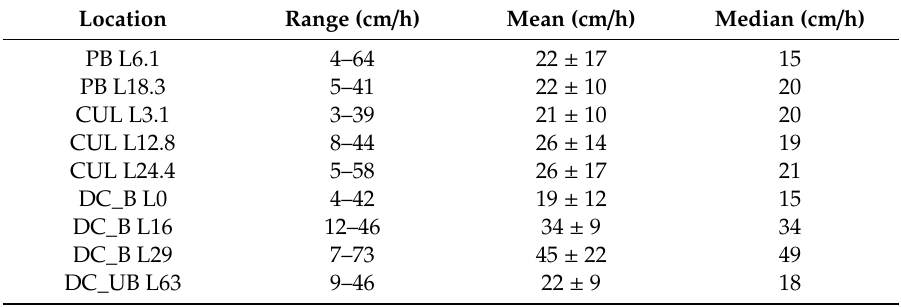
Table 2. Range, mean, and median infiltration rates (cm / h) for the unburned pedestrian bridge (PB), unburned culvert (CUL), burned Del Cerro (DC_B), and unburned Del Cerro (DC_UB) transect locations.